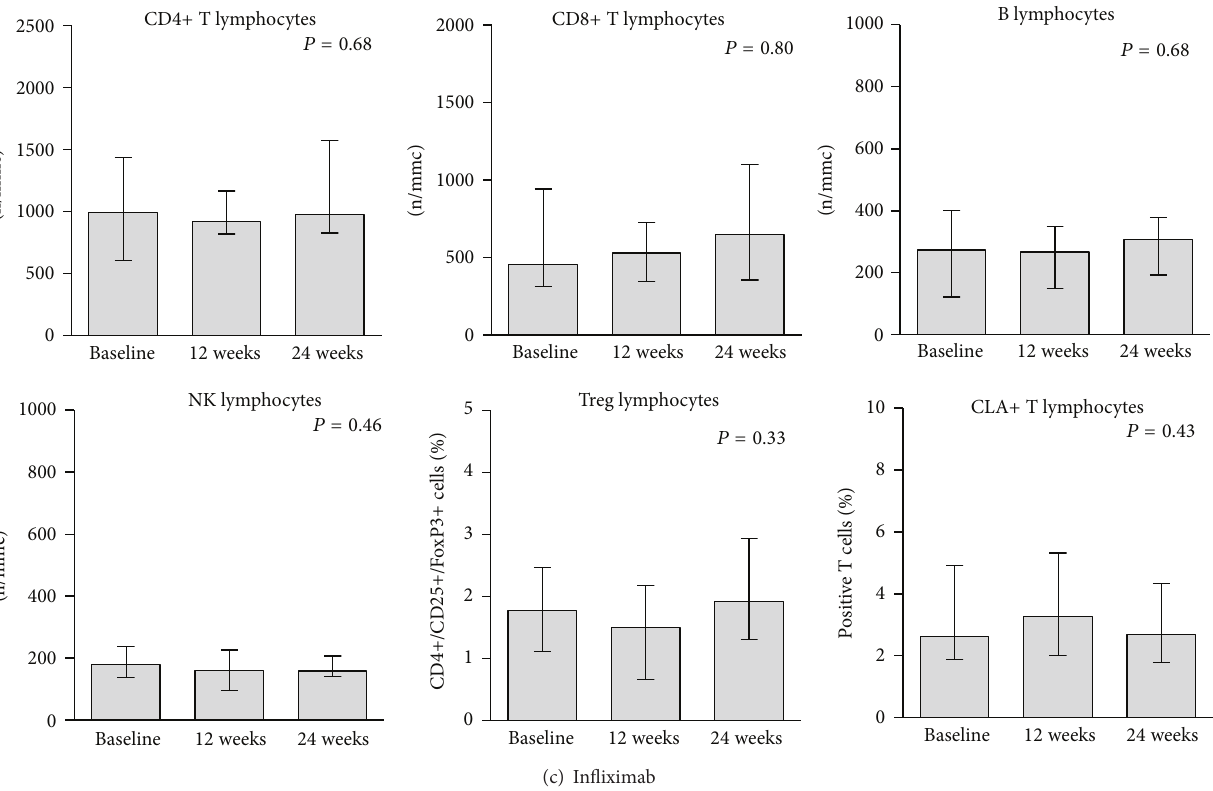
Figure 5: Analysis of lymphocyte subsets (T, B, NK lymphocytes, CD3+CLA+ and Treg cells) in peripheral blood of psoriasis patients before and during therapy with etanercept (a), adalimumab (b), and infliximab (c). Measurements were compared by one way ANOVA for repeated measures, nonparametric test. Depicted values are median and interquartile